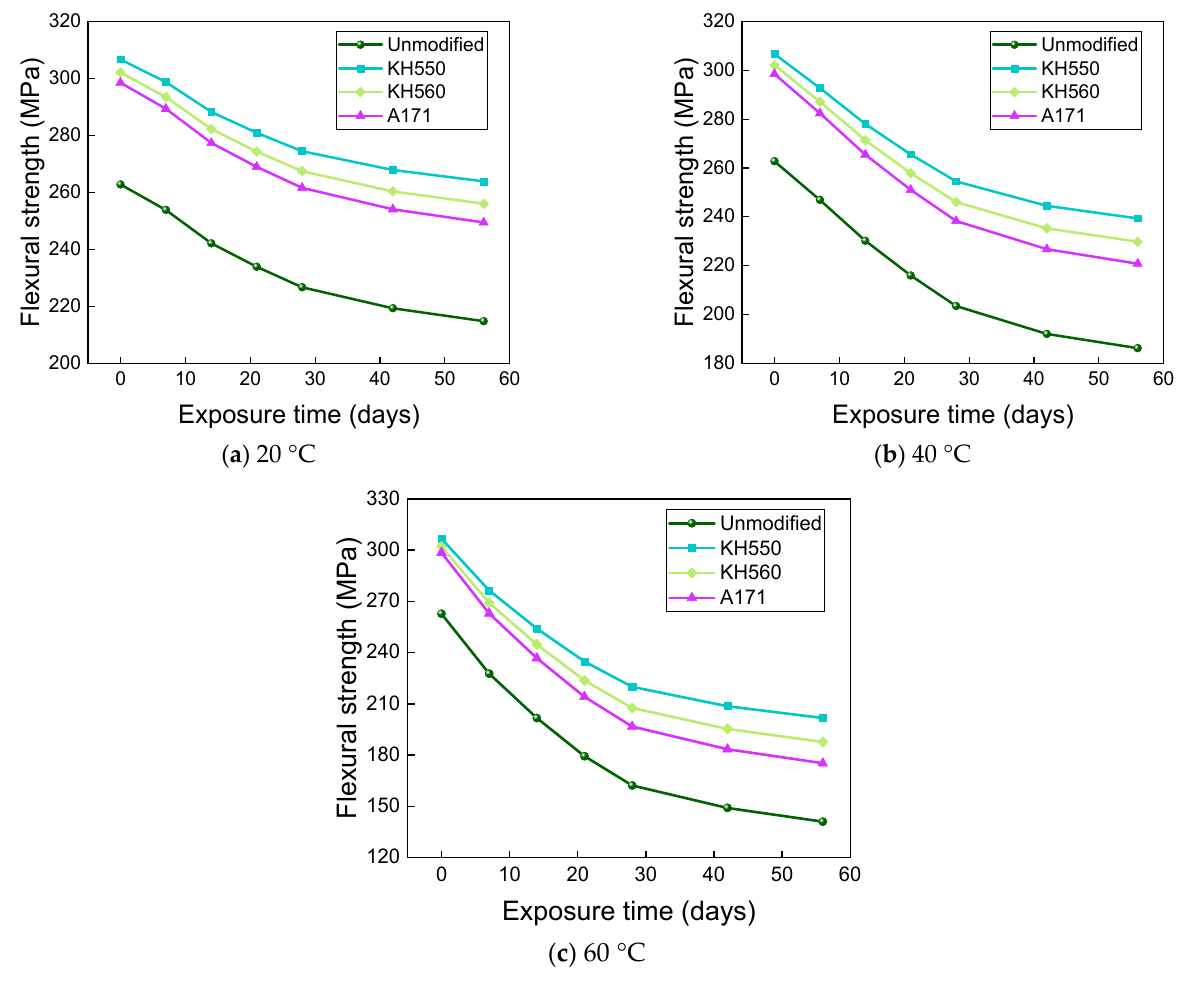
Figure 25. Flexural strength in a 10% H 2 SO 4 acidic environment.